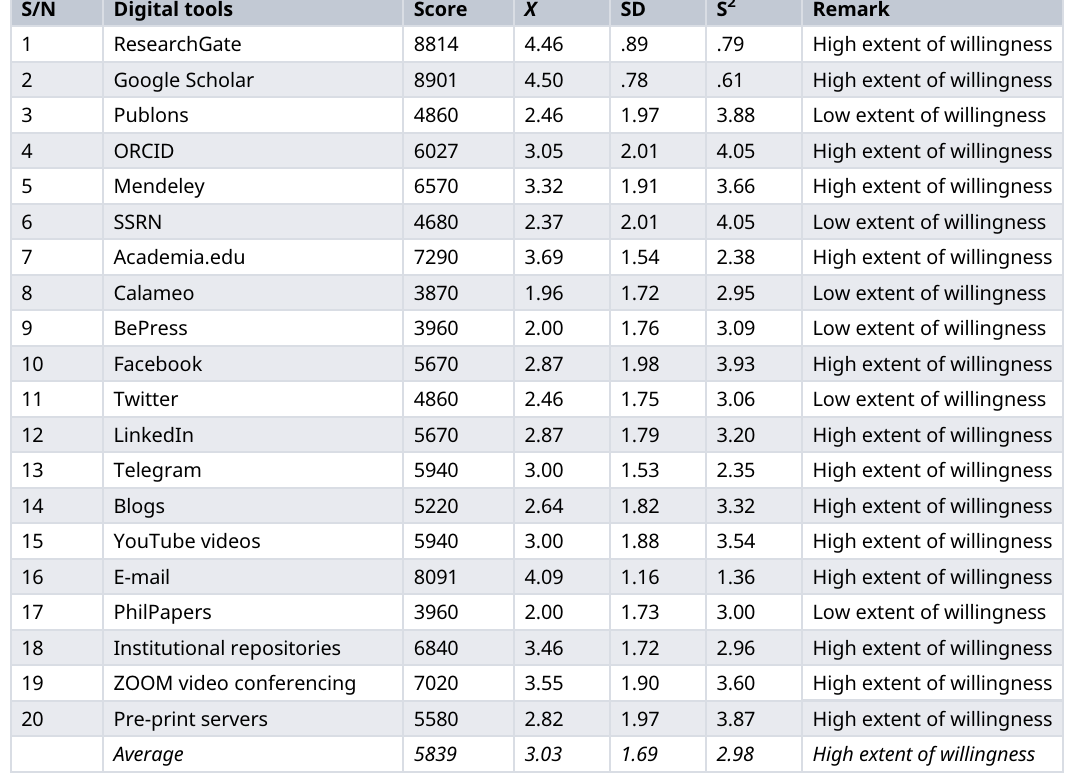
Table 1. Extent of respondents ’ willingness to adopt digital tools for research dissemination in Africa (N =